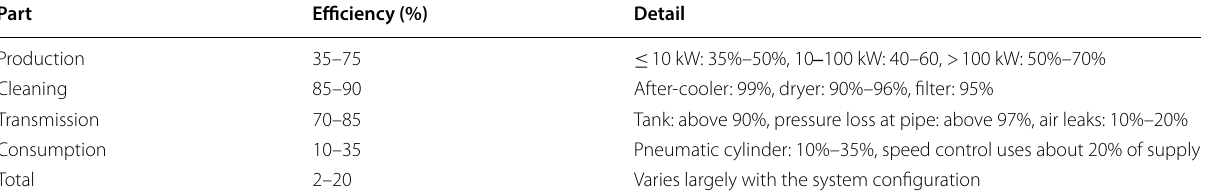
Table 6 Power flow in pneumatic cylinder actuating systems Part